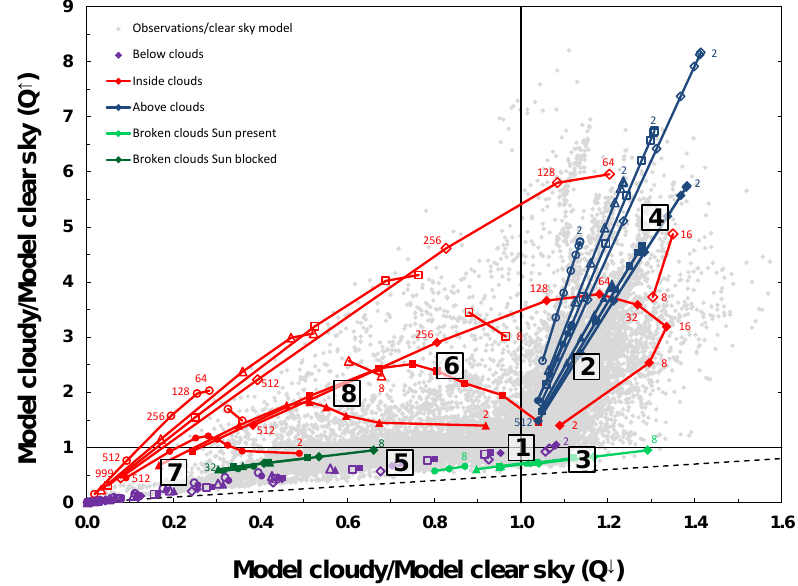
Fig. 7. Correlation of cloudy-model to clear-sky-model actinic flux ratios for up-welling and down-welling radiation, for selected ranges of cloud conditions as indicated in the legend. Grey points are observations/clear-sky model ratios from Fig. 6. Large numbers refer to cases from Table 2. Small numbers give cloud optical depths (range 2–999), for cloud between 3 and 4km. Closed and open markers denote different surface elevations (sea level and 2km, respectively). Airplane altitude is 2.5, 3.5, and 4.5km for below, inside, and above cloud, respectively. Calculations at solar zenith angles of 0, 45, 60, and 80 degrees are given by diamonds, squares, triangles, and circles,